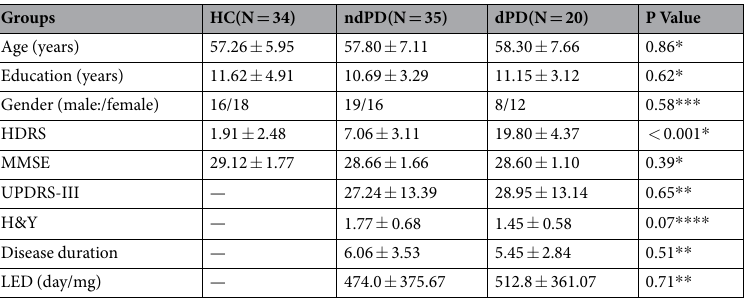
Table 1. Demographic and clinical characteristics of the total sample. * Comparisons of Age, Education, HDRS and MMSE among three groups used one-way ANOVA; ** Differences of HARS, UPDRS-III, Disease duration and LED between ndPD and dPD calculated using two-sample t test; *** Gender distribution in three groups assessed by chi-squared test; **** Comparison of H&Y between ndPD and dPD utilized Wilcoxon rank sum test. Abbreviations: HC, healthy control; ndPD, non-depressed Parkinson’s disease; dPD, depressed Parkinson’s disease; HDRS, Hamilton Depression Rating Scale; MMSE, Mini-Mental State Exam; UPDRS, Unified Parkinson’s Disease Rating Scale; H&Y, Hoehn&Yahr staging; LED, L-dopa equivalent daily